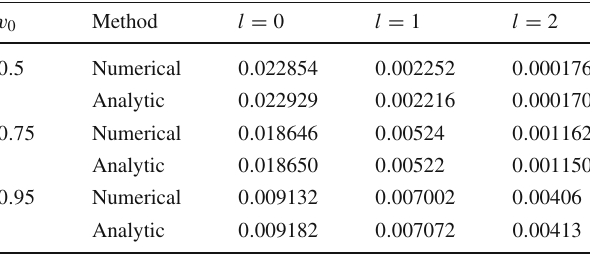
, as a function of r 0 , obtained using Eq. (28), considering Eq. (34) (plots l